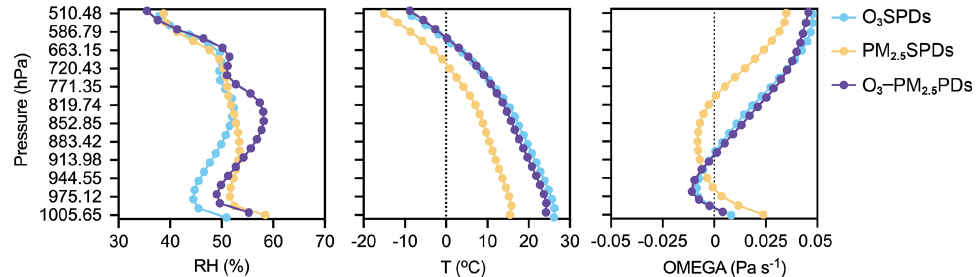
Figure 11. The vertical profiles of RH (%), T ( ◦ C), and OMEGA (Pas − 1 ) averaged over BTH and over the model-captured regional